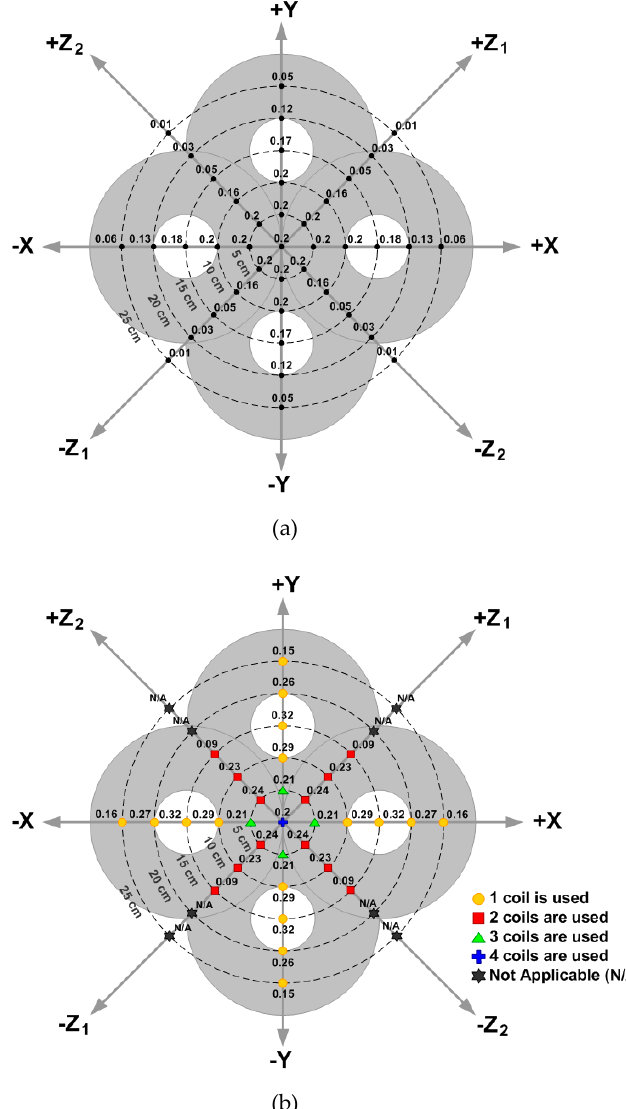
Figure 20. Measured magnetic coupling coefficient, k, at various receiver coil positions: ( a ) Without transmitter coil pattern selection; ( b ) With proposed transmitter coil pattern selection.